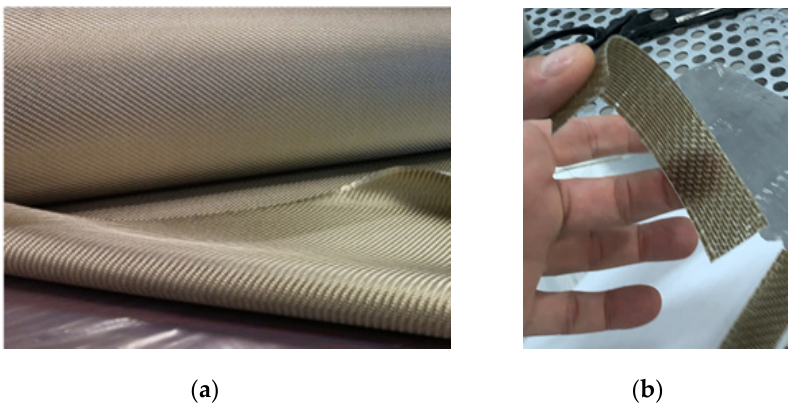
Figure 2. ( a ) Twill 2 × 2, 3K Filava fabric; ( b ) Flexible FPC specimen of 0.5 mm thickness.